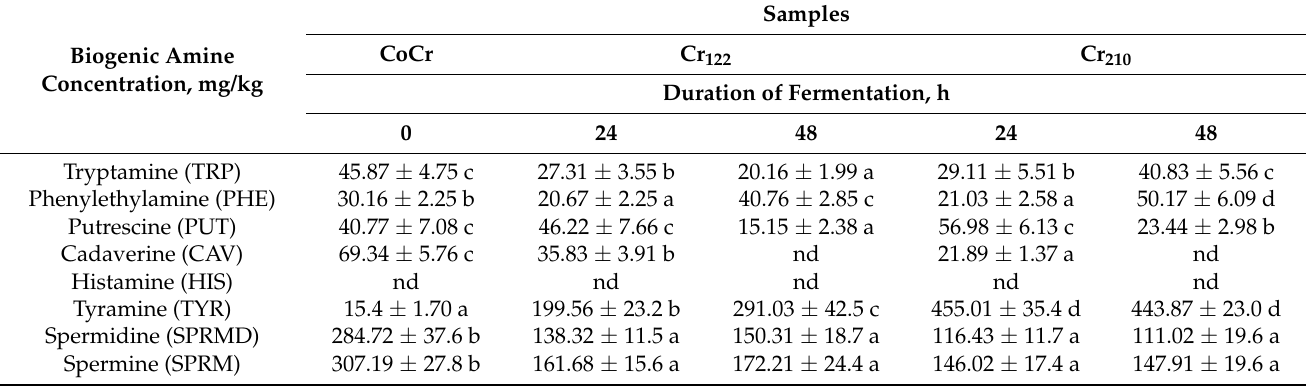
Table 2. Biogenic amine (BA) concentration (mg/kg) in non-treated and fermented cricket flour